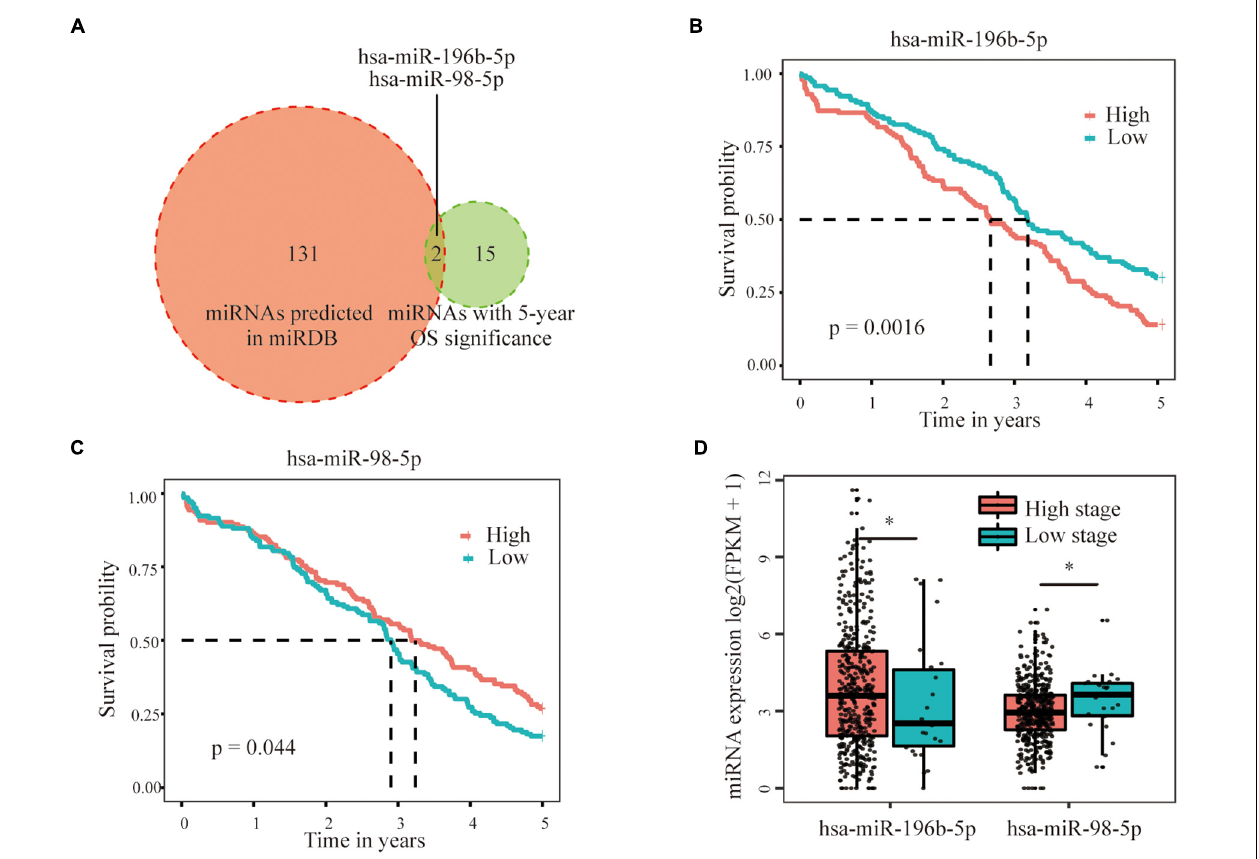
FIGURE 6 | Predicted miRNAs targeted the three selected m6A RNA methylation regulators. (A) Two miRNAs, namely, hsa-miR-196b-5p and hsa-miR-98-5p, with potential binding sites in the IGF2BP1 sequence that were significantly related to the prognosis of patients with OC were selected based on miRbase and survival relationships. (B) Patients with OC presenting high hsa-miR-196b-5p expression showed an obviously decreased survival rate compared with those with low hsa-miR-196b-5p expression, indicating its oncogenic role in OC. (C) Patients with OC presenting high hsa-miR-98-5p expression showed an increased survival rate compared with those with low hsa-miR-98-5p expression, suggesting its potential tumor-suppressive function in OC. (D) The expression of hsa-miR-196b-5p was increased, but hsa-miR-98-5p expression was decreased in the high-stage group compared with the low-stage group * P <